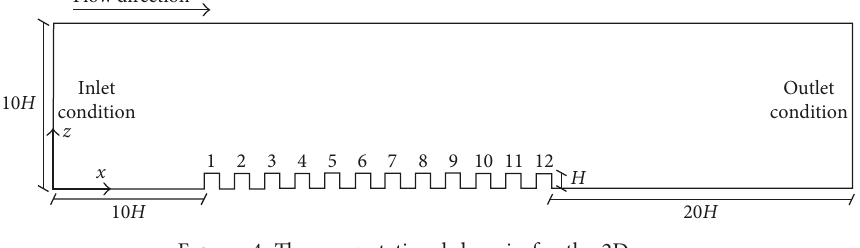
Figure 4: The computational domain for the 2D